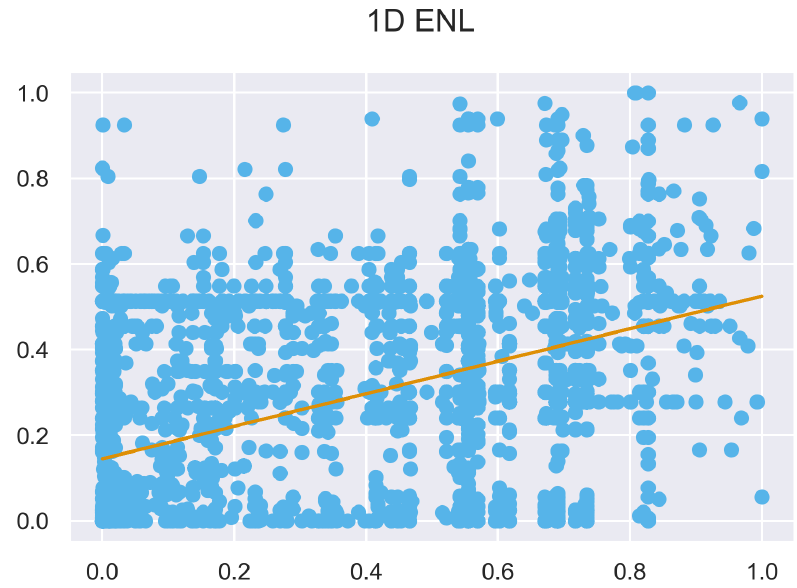
Figure A24. ULS and TLS 1 D ENL regression at 1m grid size.